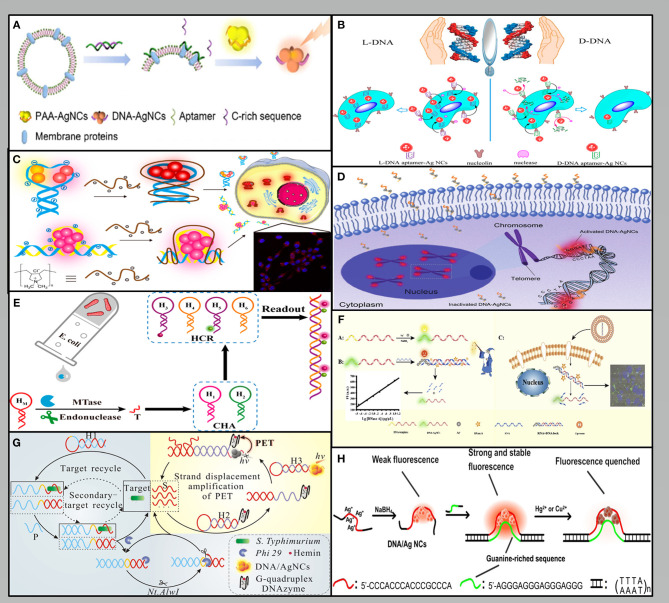
Methods used for fluorescence signal output: (A–C) The fluorescence signal is based directly on DNA-AgNCs (Han et al., 2016; Liu et al., 2017; Lyu et al., 2019). (D–F) The fluorescence signal is based directly on DNA-AgNCs (Huang et al., 2018; Li et al., 2018a; Dang et al., 2020). (G) The fluorescence signal is based on PET (Leng et al., 2018). (H) The fluorescence signal is based on reactive quenchers (Peng et al., 2015).